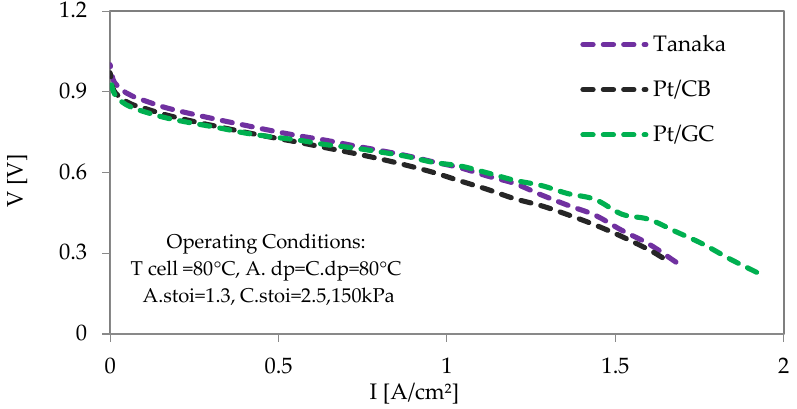
Figure 6. Comparative I–V characteristic curves of the MEAs using a Nafion ® NR212 membrane with Pt/CB, Pt/GC, and Tanaka catalysts.